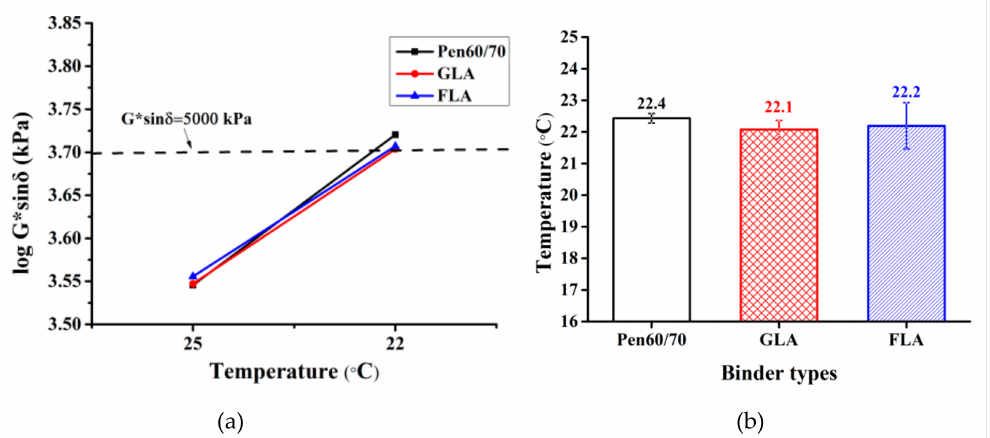
Figure 5. Superpave fatigue factor test results: ( a ) fatigue factor (long-term aged) and ( b ) failure temperatures (long-term